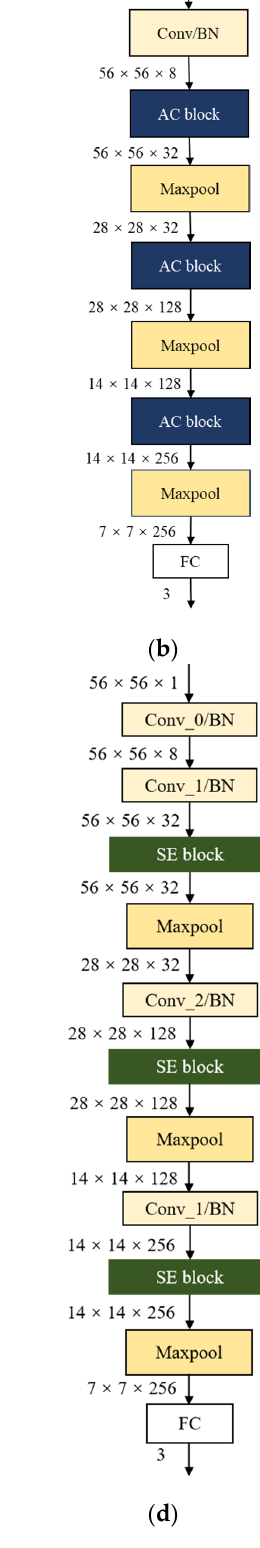
Figure A1. Structure of the four CNNs. ( a ) Structure of EAC block network; ( b ) structure of AC block network; ( c ) structure of DPIC_SE block network; ( d ) structure of SE block network.